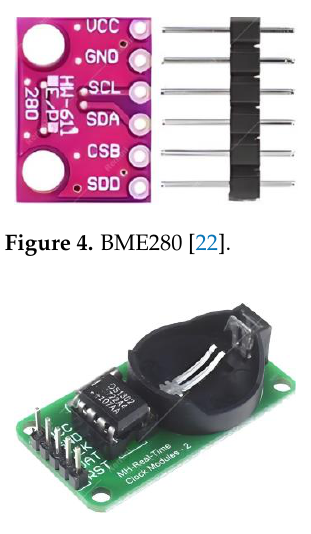
Figure 3. Arduino UNO R3 [21].